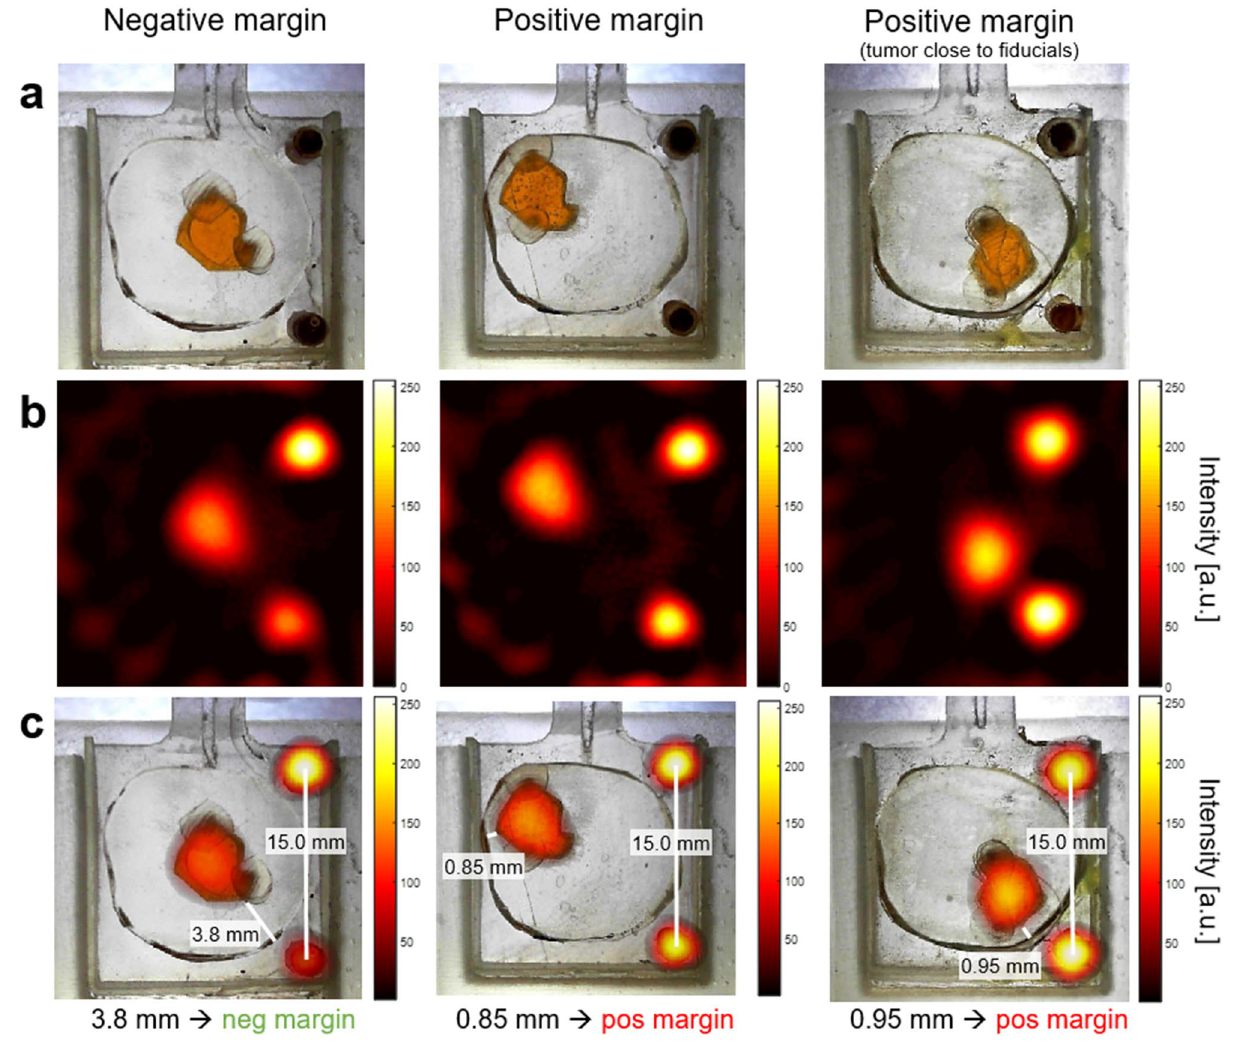
Figure 11. Lumpectomy specimen phantoms, MPI images, and co-registration. (a) Optical images of lumpectomy specimen phantoms. The “tumor” is a cavity with a maximum diameter of ∼ 6.5 mm filled with 0.5 mg/mL VivoTrax (51.2 µg total Fe quantity). The fiducials are 1.75 mm diameter cylinders filled with undiluted (5.5 mg/mL) VivoTrax (61.1 µg total Fe quantity). The “healthy tissue” is 3D print material containing no SPIOs. Negative margin is defined as tumor > 1 mm from specimen’s surface; positive margin is defined as tumor ≤ 1 mm from surface. (b) Each MPI image is acquired in 10.7 s using a triangular-waveform shift field with 27 projections, 66 readouts per projection, and 150 Tx cycles per readout. Receive chain has total G = 1000. Image reconstructed with model-based preconditioned conjugate gradient recon. Each MPI image is scaled to its individual maximum. (c) MPI images from ( b ) are co-registered with the optical images of the phantoms from ( a ) using the fiducial locations. The distances between the tumor edge and the specimen margin are measured (using the Distance Tool in MATLAB (R2018b, https://www.mathworks.com/products/matlab.html)), correctly classifying the specimen phantoms as negative or